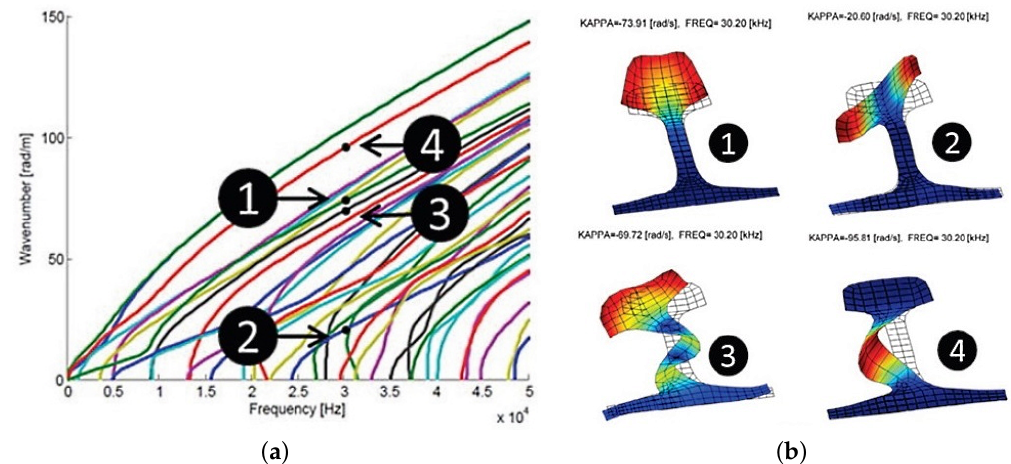
Figure 10. Dispersion curves ( a ) and mode shapes ( b ) observed in a rail waveguide. Some candidate modes for long range damage detection are highlighted. Modes 1 and 2 are symmetric and anti-symmetric, respectively, and their energy is concentrated in the crown of the considered rail; the energy of mode 3, instead, is more evenly distributed across the rail cross section (a small portion of it is observed in the foot), whereas that of mode 4 is concentrated in the web of the rail (pictures taken from Ref.